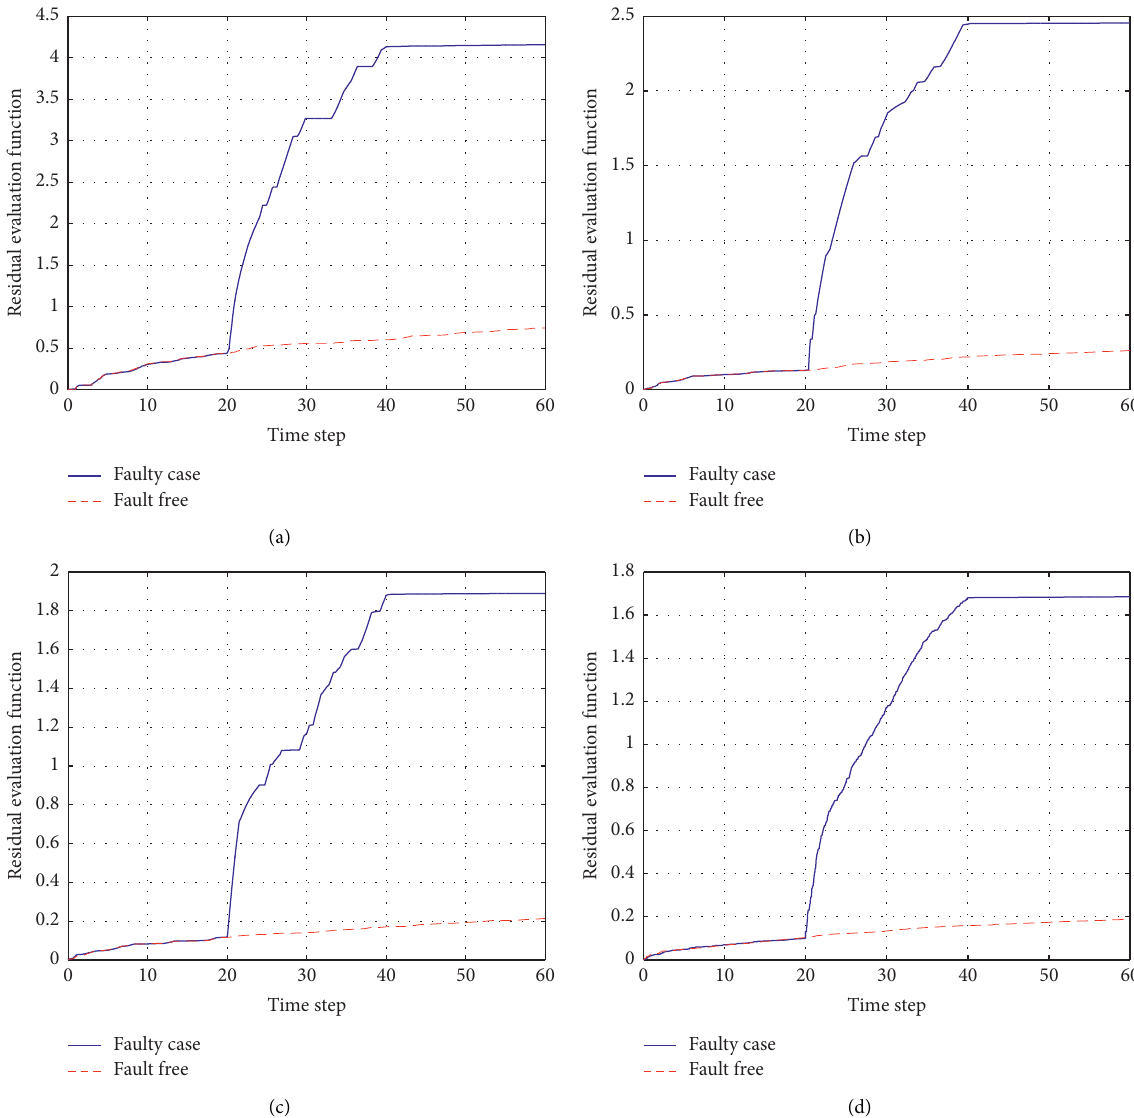
Figure 4: Residual evaluation function curves of full-order FDF for four different TRMs cases. (a) Case 1. TRM is completely known. (b) Case 1. TRM is polytopic uncertain. (c) TRM is partly unknown. (d) TRM is completely